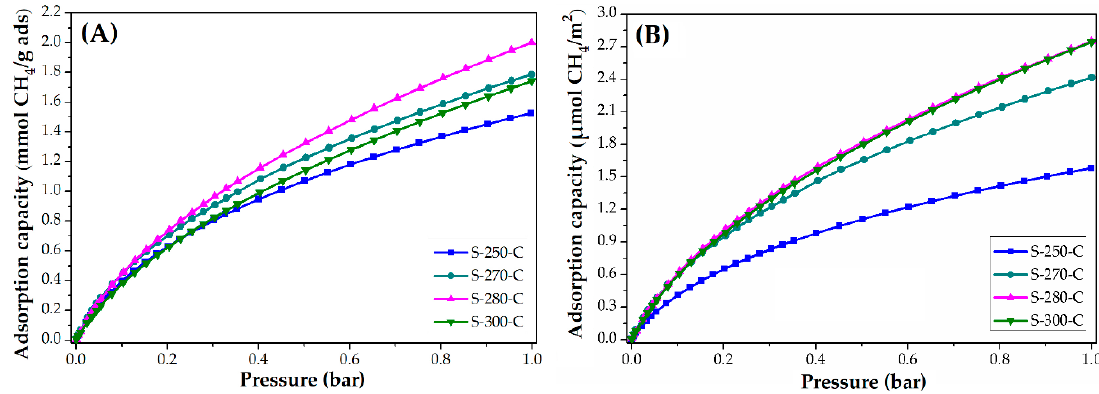
/ g adsorbent and ( B ) µ mol CH